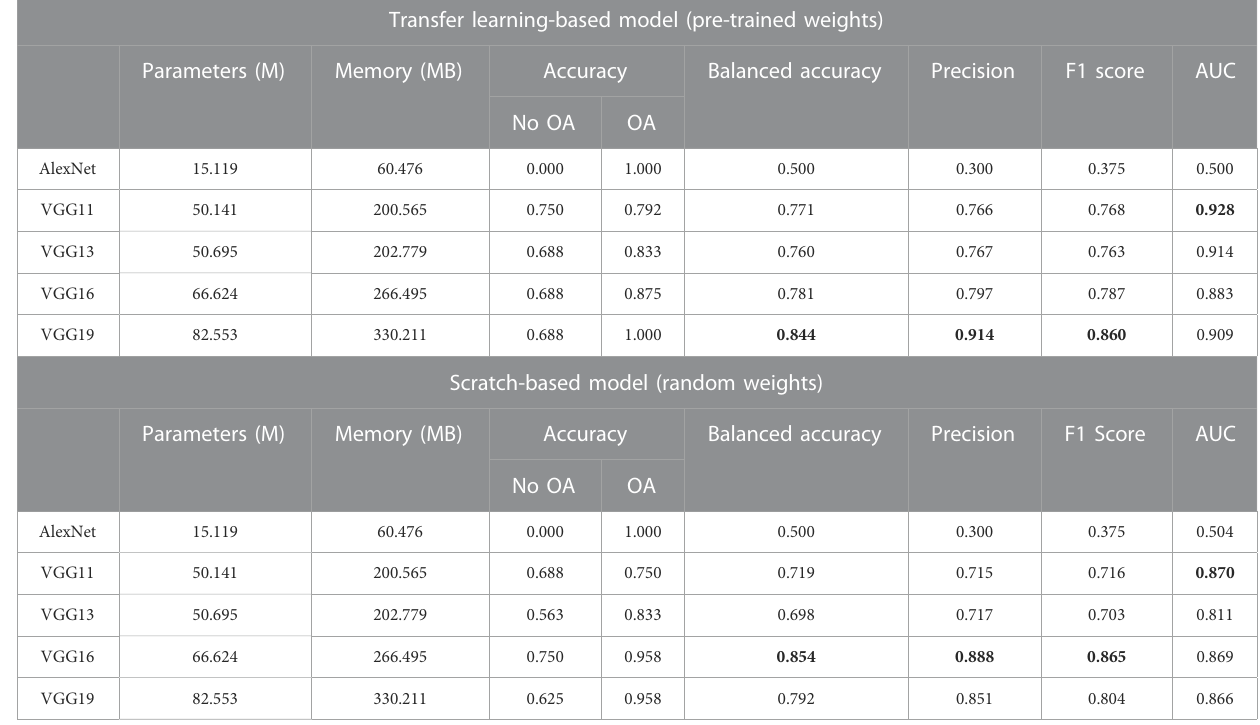
TABLE 4 Performance comparison of AlexNet and VGG variants.